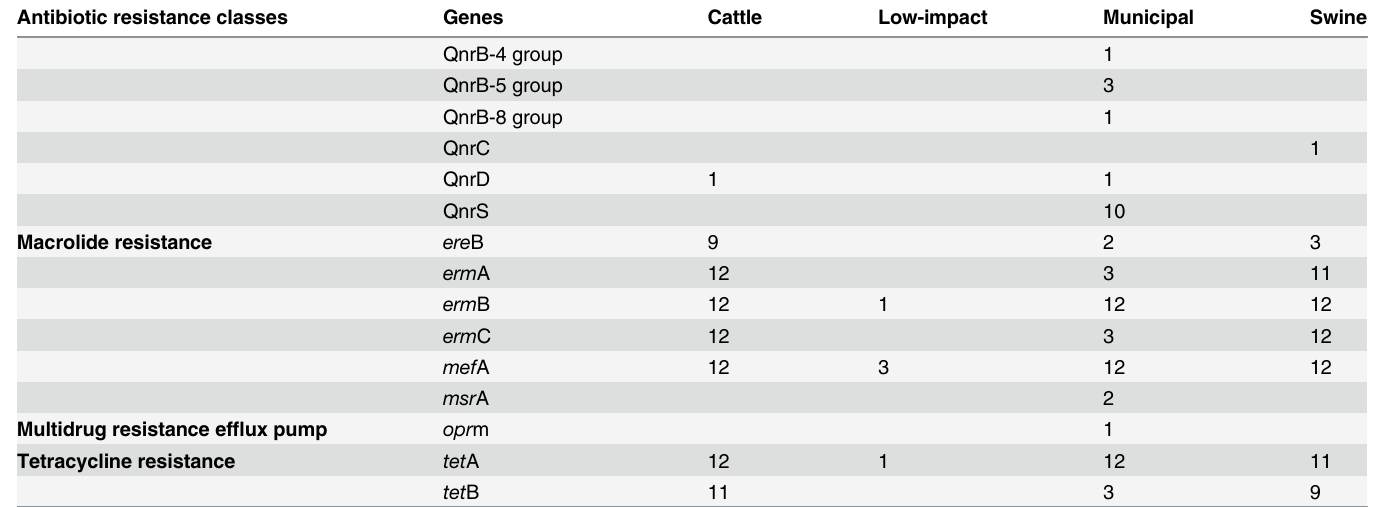
were negative for any of the resistance genes targeted. The top ten most prevalent resistance genes for all pooled samples (occurring in > 50% of all samples) were aminoglycosides ( aadA1 ) and aminoglycosides/fluoroquinolone resistance ( aac(6')-Ib-cr ), class D beta-lactamases resistance ( ermA , ermB , ermC , and mefA ) and tetra- (OXA-2 group and OXA-10 group), MLS B cycline efflux genes ( tet A and tet B). The median number of antimicrobial resistance genes detected per pooled sample was 19.5 (range: 9-38), 12.5 (range: 7-21), 12 (range: 8-16), and 1.5 (range: 0-5) in the municipal, swine, cattle, and low impact environment samples, respectively. The median number of antimicrobial resistance genes detected per sample from low impact environments was significantly ( P = 0.0001) lower than the corresponding median values among livestock and municipal samples (Fig 1)